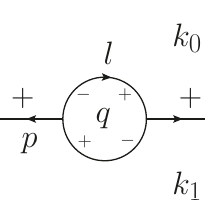
Figure 16 . The gluon (++) self-energy diagram. q is the region momentum associated with the loop and k with the external region. l is the loop momentum and p is the external line i